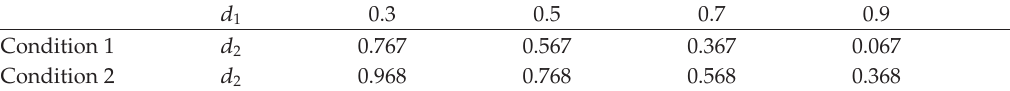
Table 2: Allowable upper bound of d